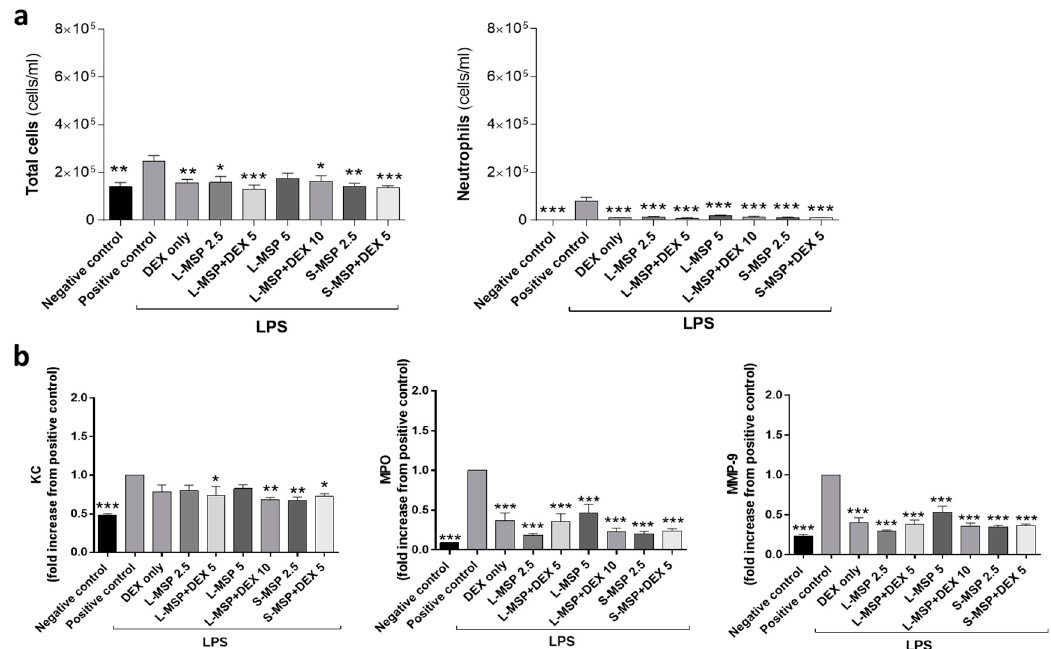
Figure 3. ( a ) Total leukocytes and the total number of neutrophils in bronchoalveolar fluid (BALF) and ( b ) analysis of KC, MPO, and MMP-9 in the BALF from the mice exposed to lipopolysaccharide (LPS). Values indicate means ± SEM; * p < 0.05, ** p < 0.01, *** p < 0.001 compared to the LPS group receiving vehicle. MSP—mesoporous silica particle (L: large, S: small); DEX—dexamethasone. Positive control: HEPES buffer administered to the mice exposed to MEL/LPS; negative control: HEPES buffer administered to healthy mice; DEX only: 5 mg/mL (free DEX/HEPES buffer). The numbers on the x-axis denote mg/mL (particles/HEPES buffer). Each bar represents a group of n = 6 animals.